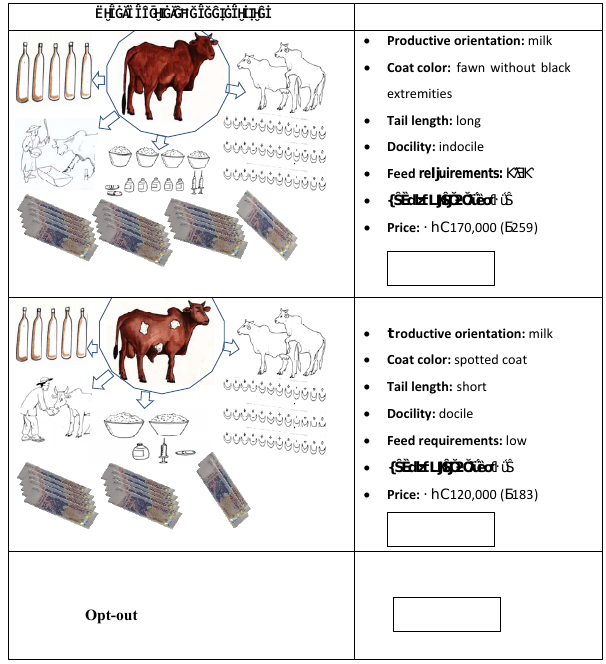
Figure 1. Example of pair-wise comparison choice